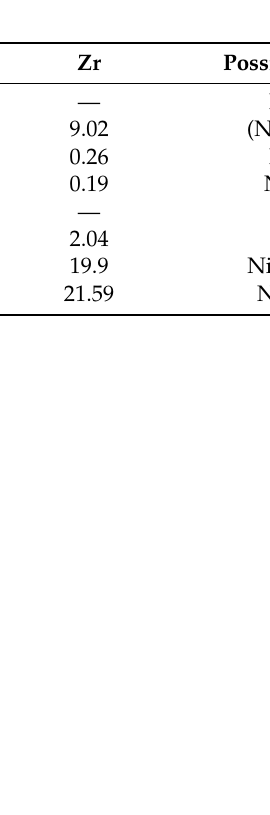
Figure 7. XRD results of the interlayer